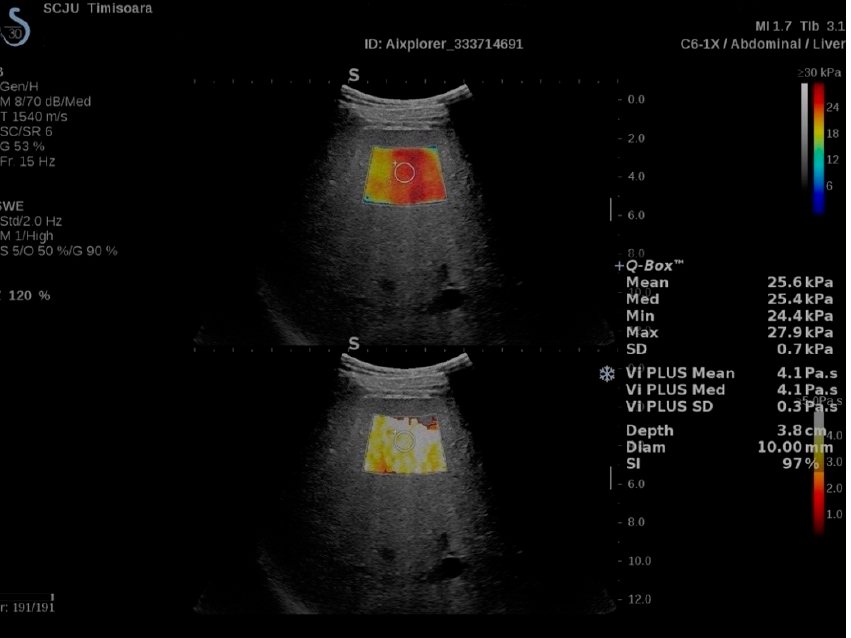
Figure 1. Illustration of a ShearWave PLUS Elastography (2D-SWE.PLUS) and Vi.PLUS measurement performed in a cirrhotic patient. Two color scale maps are displayed. In the SWE map, displayed in the upper part of the image, no fibrosis is color-coded with blue, while red signifies severe fibrosis. The viscosity is displayed in the lower part of the image. Colors close to yellow-white indicate high viscosity, while red signifies low viscosity, numeric 2D-SWE.PLUS results (expressed in kPa) and of Vi.PLUS (expressed in Pa.S) are displayed on the right side of the image. The Q-Box displays the mean, median, minimum, maximum, and standard deviation (SD) of the measurements, along with the depth, the diameter of the ROI, and the Stability Index (SI).